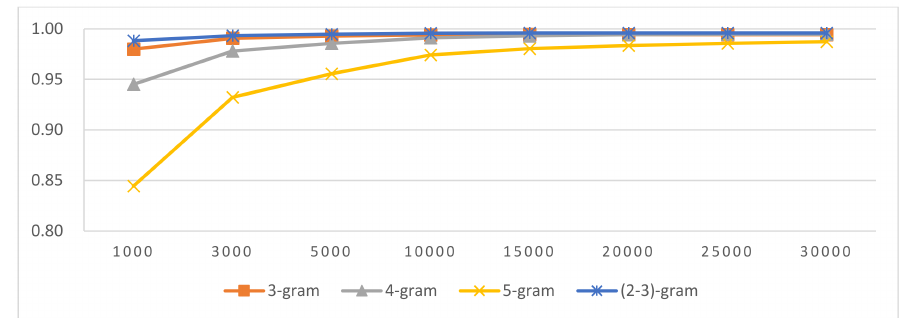
Figure 20. LI in Austronesian-Malayo/Polynesian (MP) in Latin.